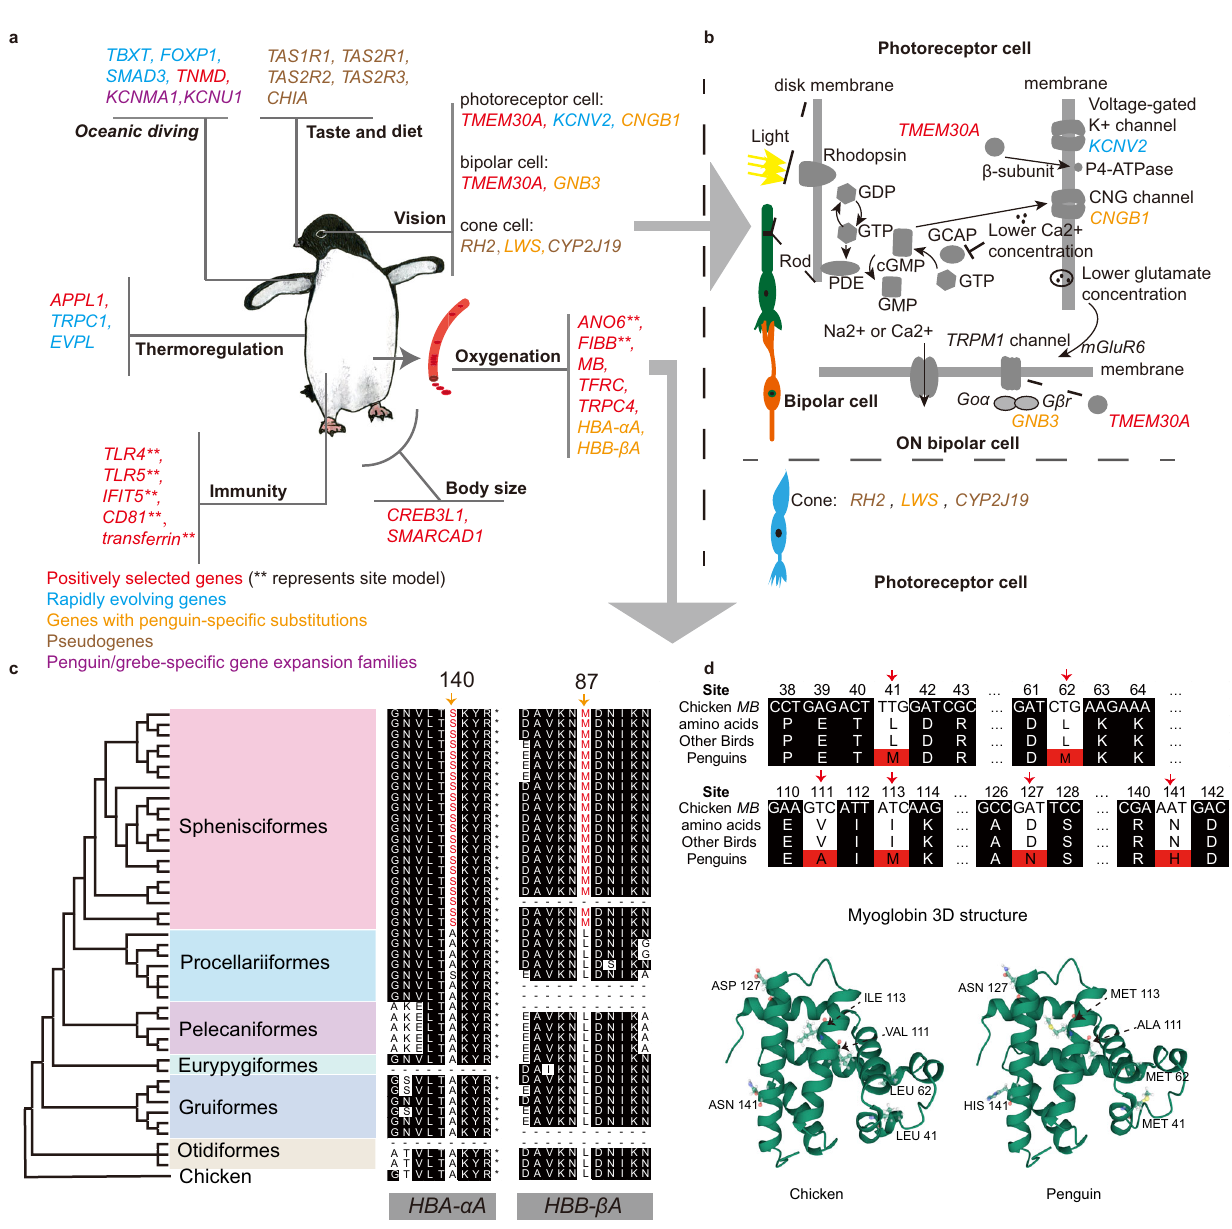
Fig. 4 Adaptive genes in extant penguin lineages. a Genes with unique evolutionary signals in penguins and their putative adaptive function. b Gene regulatory pathways related to light transmission. c Phylogenetic tree of 45 avian species showing two mutation sites ( HBA- α A , A140S, and HBB- β A , L87M) of hemoglobin genes in penguins (marked in red) and outgroups. d Positive selection at multiple sites (41, 62, 111, 113, 127, 141) on the bLCA of extant penguins for MB gene and the structural effects of amino acid substitutions in the chicken MB gene. Molecular models of the chicken MB gene and the MB gene with penguin-speci fi c substitutions may affect the stabilization of MB . Source data is provided as a Source Data fi le.